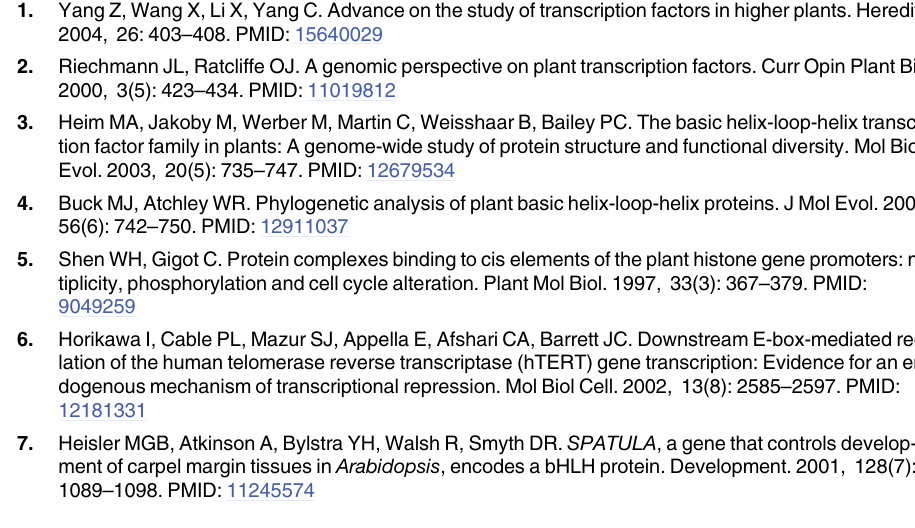
S1 Fig. qRT-PCR analysis of TFs between mapping parents. The expression levels of Emian22 and 3 – 79 are presented. “ (cid:1) ” represents P (cid:3) 0.05, and “ (cid:1)(cid:1) ” represents P (cid:3) 0.01. The fol- lowing primers were used: A, TF-Ghi001138-1; B, TF-Ghi003946-2; C, TF-Ghi005868; D, TF-Ghi016740. S1 Table. Characteristics of the 977 TF primers used in this study. ×: Non-polymorphic primers. -: The primer was not mapped on the